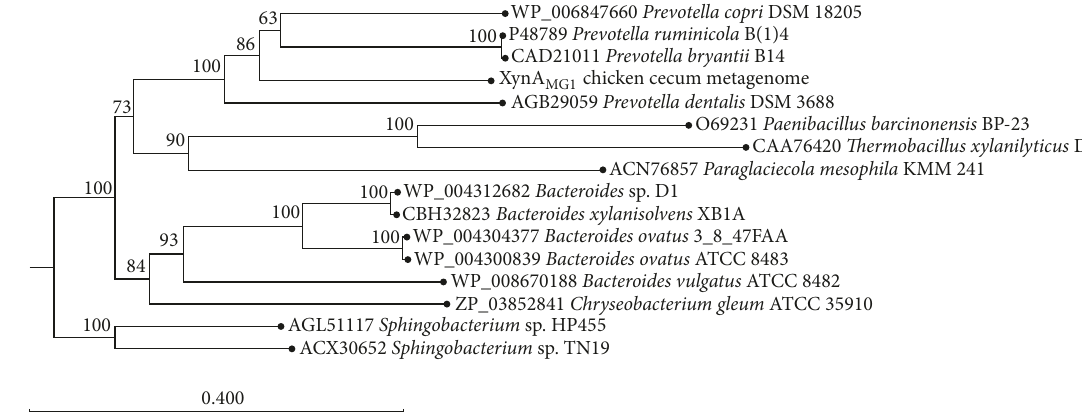
Figure 2: Phylogenetic analysis based on the amino acid sequence of XynA MG 1 and related GH10 family xylanases. The phylogenetic tree was constructed using the neighbor joining method (CLC Main Workbench version 7.7). The lengths of the branches indicate the relative divergence among amino acid sequences. The percentage bootstrap values based on 1,000 bootstrap replications are shown at the nodes. Xylanases of Sphingobacterium sp. TN19 and Sphingobacterium sp. HP455 are used as outgroups. Accession numbers of the xylanase amino acid sequences are shown with the names of the host organisms. The scale bar represents the number of changes per amino acid position.